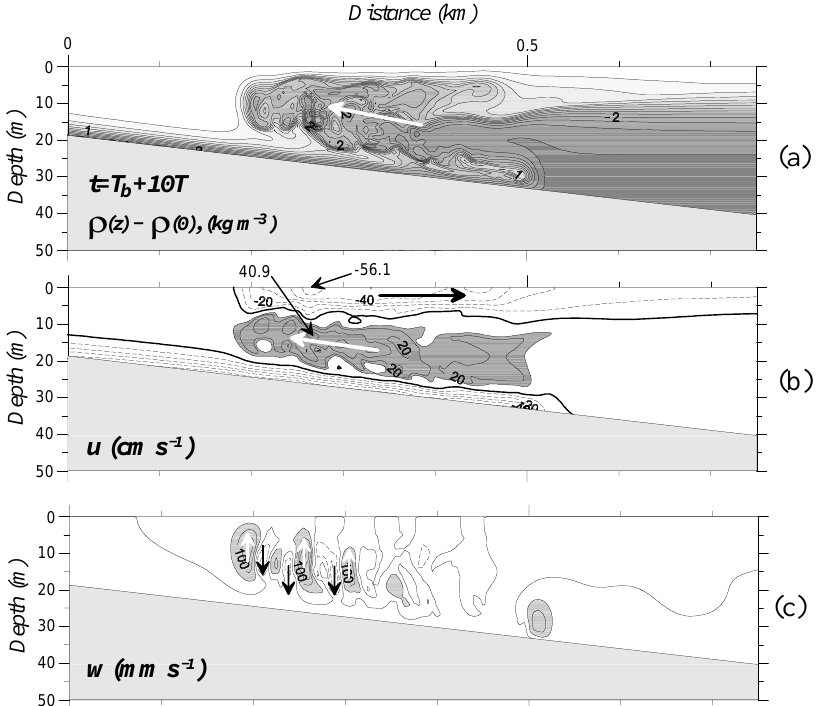
Fig. 10. Fields of the density anomaly (top panel), horizontal u and vertical w velocities (middle and lower panels, respectively) 830s after breaking of the rear wave face. The contour interval for density equals 0.2kgm − 3 , those for the horizontal and vertical velocities are presented in the figures. White and black arrows in the two upper panels show the direction of propagation of the density intrusion. White and black arrows in panel (c) indicate down- and upwelling,